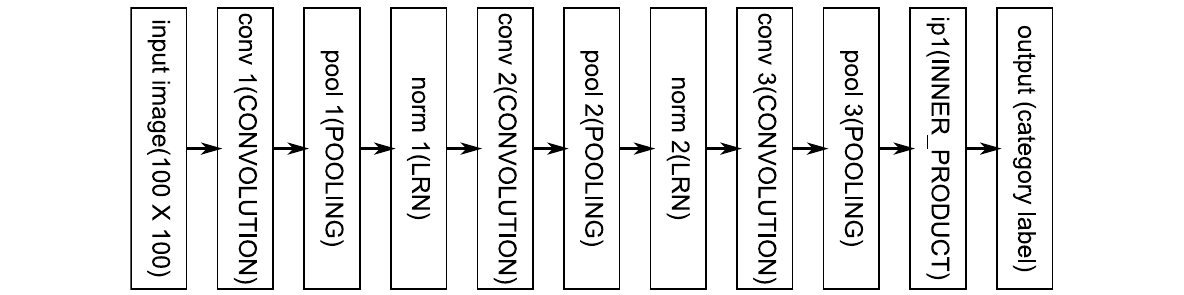
Fig. 3 Structure of convolutional deep neural network